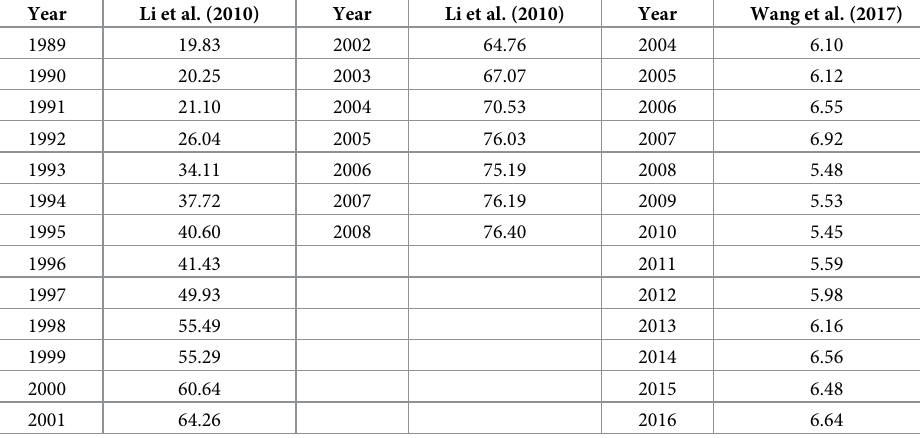
Table 3. Labor marketization index in China (existing results are listed).